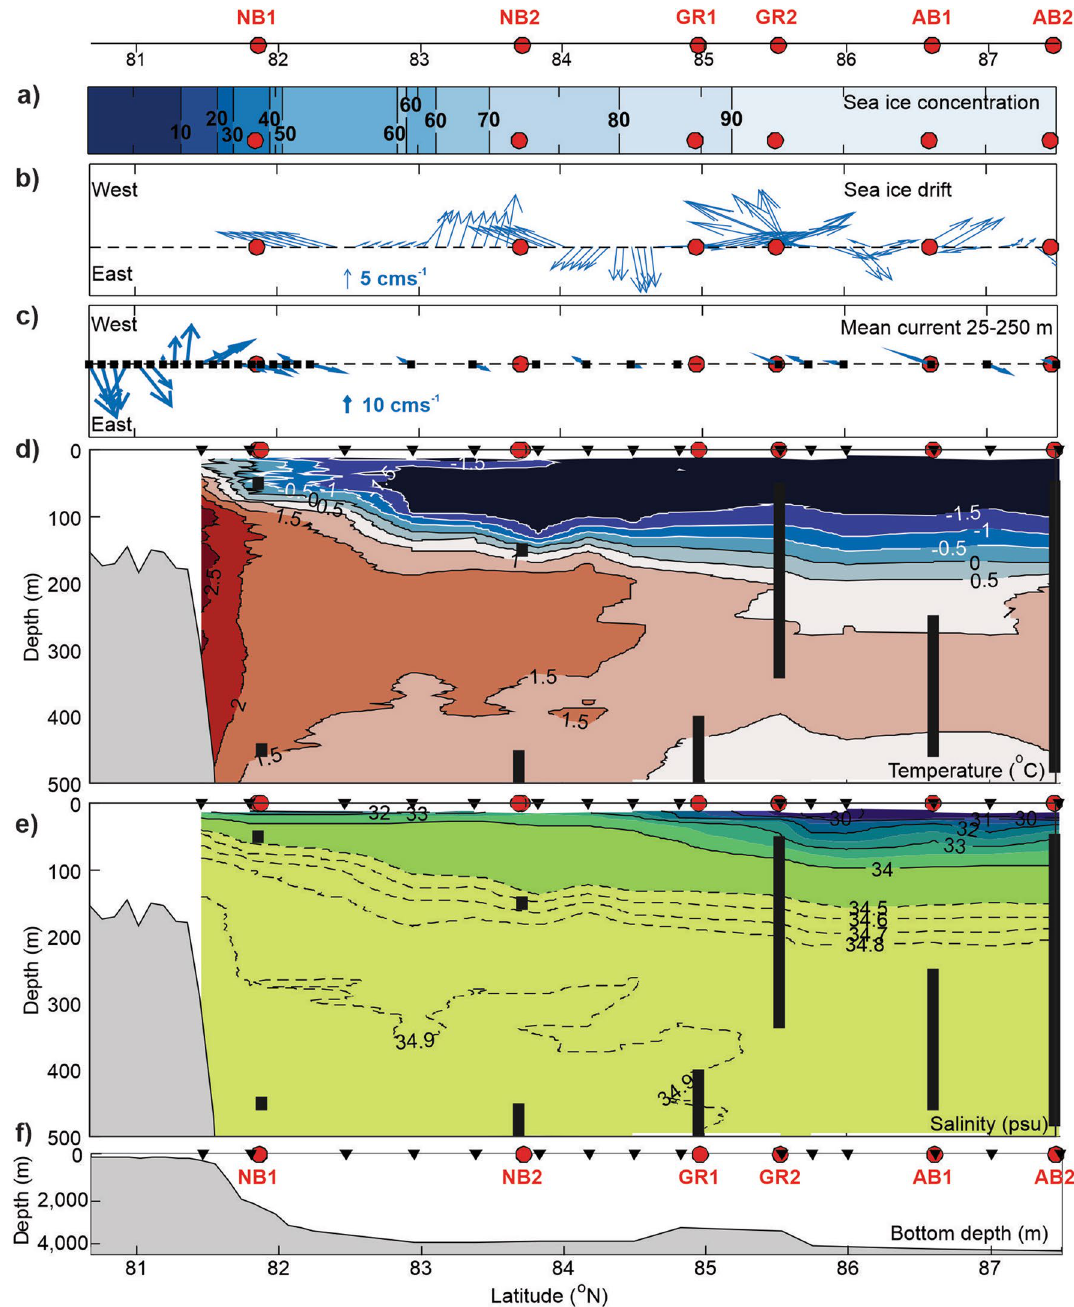
Figure 2. Environmental conditions in the Eurasian Basin in September 2021. Mean sea ice concentration during the survey ( a ) and sea ice drift at the time of sampling ( b ). Mean ocean velocity in the 25–250 m depth layer ( c ), temperature ( d ) and salinity ( e ) in the upper 500 m. The part of the water column covered by the trawl hauls (Harstad or macroplankton or both) are shown with (in d and e) and bathymetry is shown in ( f ). The location of the trawl locations ( ) and CTD stations ( ) are shown in all